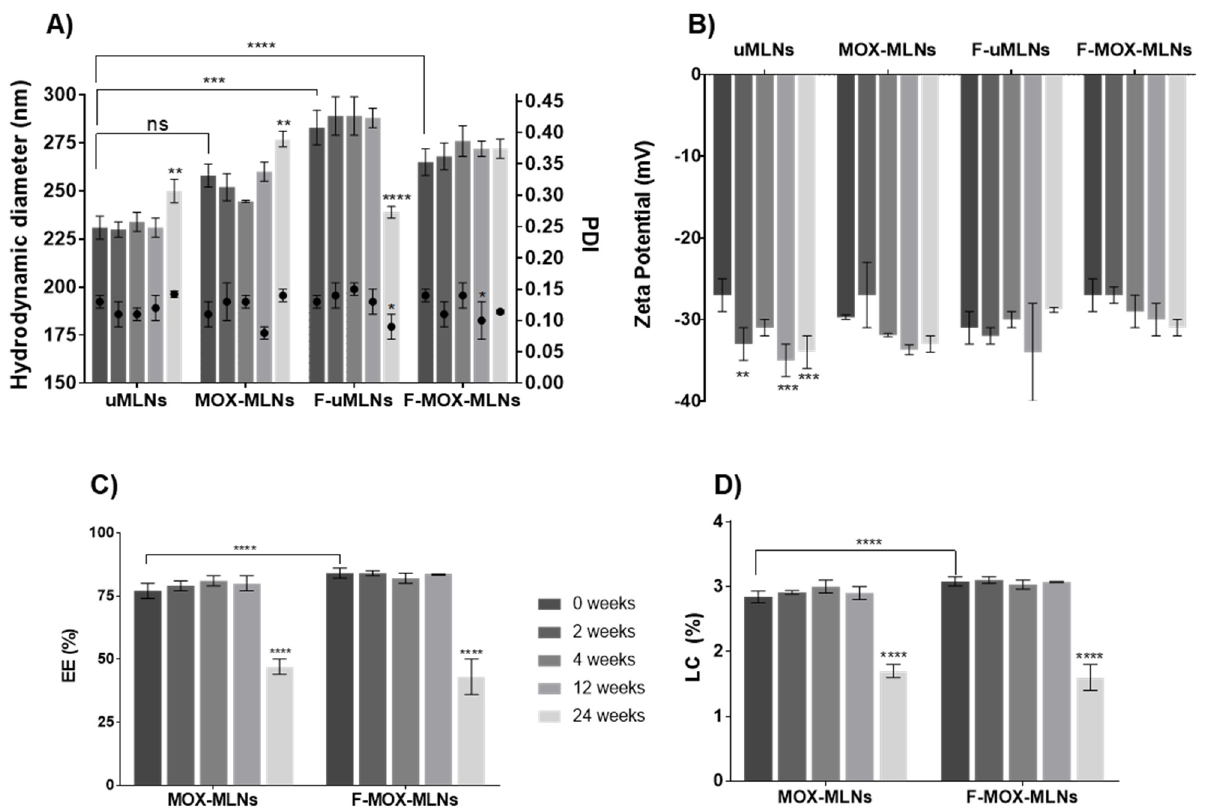
Figure 2. Characterization of the MLN suspensions over 24 weeks, stored at room temperature. ( A ) Hydrodynamic diameter and PDI. The bars represent the hydrodynamic diameter (left y -axis) and the dots represent the PDI (right y -axis). ( B ) Zeta potential. ( C ) EE. ( D ) LC. The parameters were evaluated at different time points (0, 2, 4, 12, and 24 weeks). The values are presented as the mean ± SD. ** p < 0.01, *** p < 0.001, relative to 0 weeks. * p < 0.05, ** p < 0.01, **** p < 0.0001. ns, not significant. Statistical analysis: two-way ANOVA, Tukey’s multiple comparisons test.